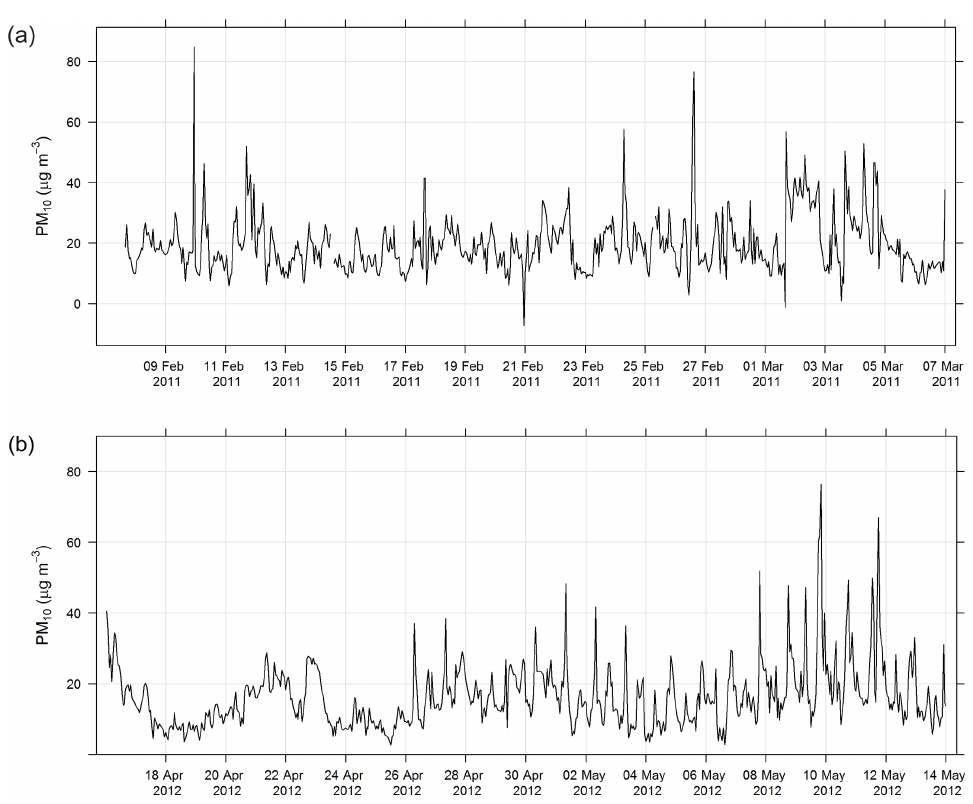
Figure 3. Time series of hourly averaged PM 10 concentrations during SPS-I (a) and SPS-II (b) .